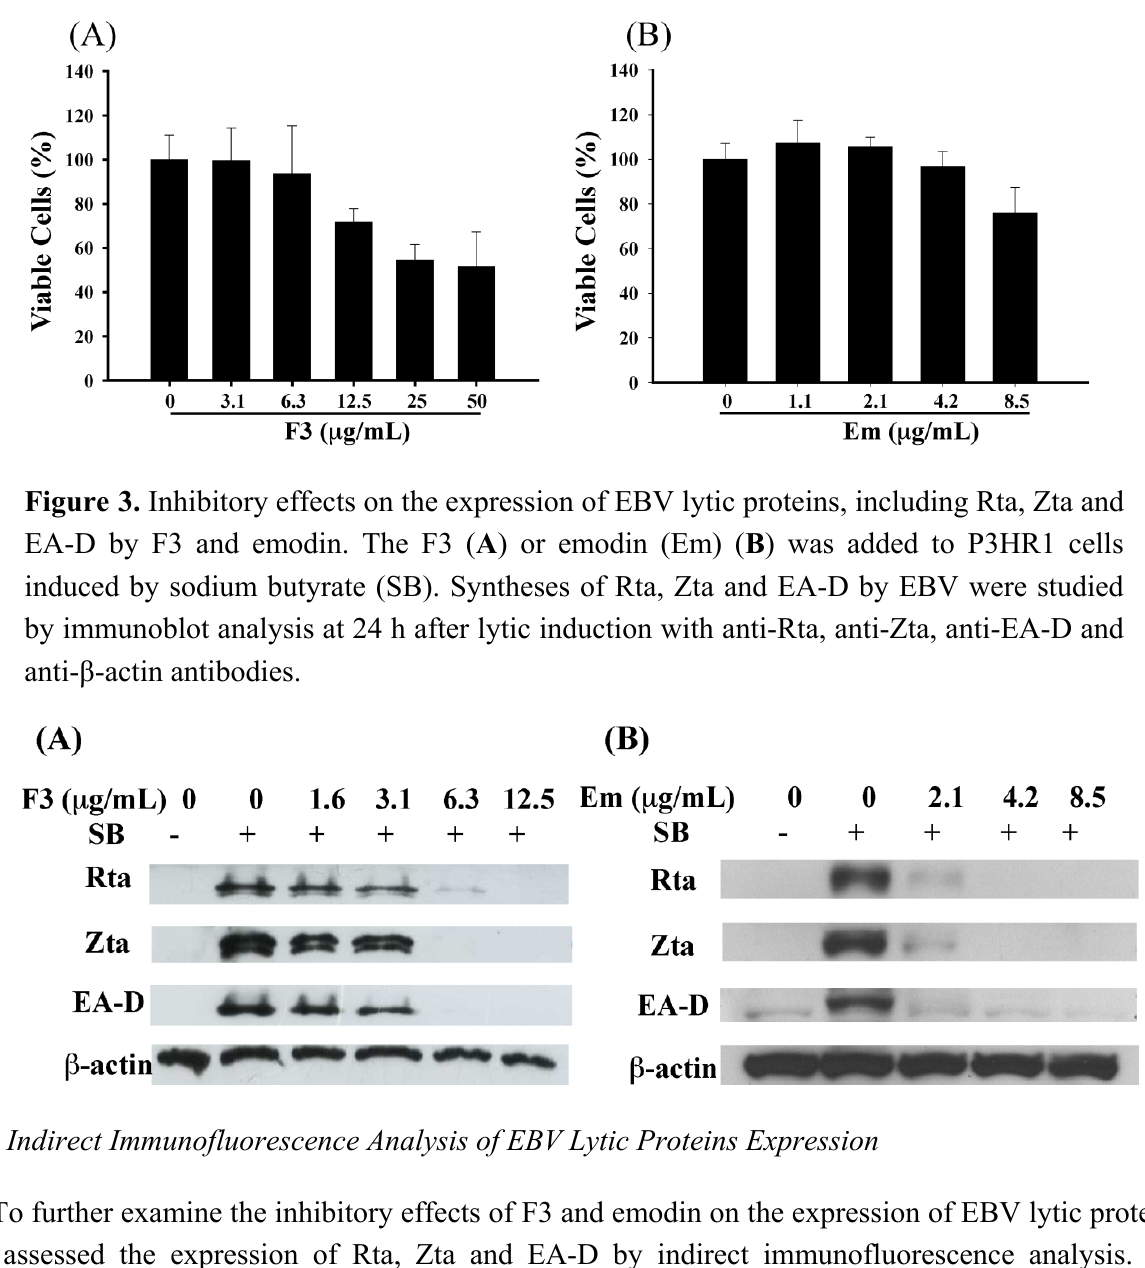
Figure 2. Effects of F3 and emodin on cell viability. P3HR1 cells (1 × 10 5 cells/mL) were treated with F3 ( A ) or emodin (Em) ( B ). Cell numbers and viability were monitored by MTT assay after 24 h of treatment.